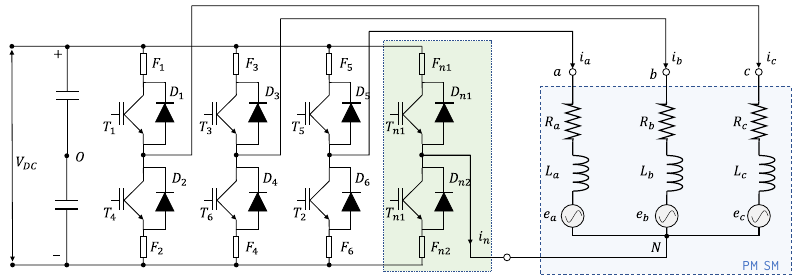
Figure 1. Four-leg inverter driving a three-phase PMSM with accessible neutral point. Independent from the selection of hardware redundancy solution, a crucial design point is always related the development of appropriate Fault-Detection and Isolation